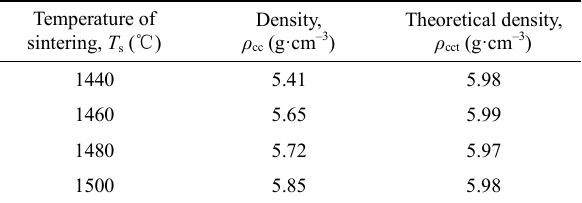
Fig. 6 Microstructure of metal–ceramic co-continuous composites (the samples in the figure are sintering at 1480 ℃ ): (a) Micro-CT model of co-continuous composites, (b, c) SEM images of cross-section of co-continuous composites surface. Table 2 Density and theoretical density of co-continuous